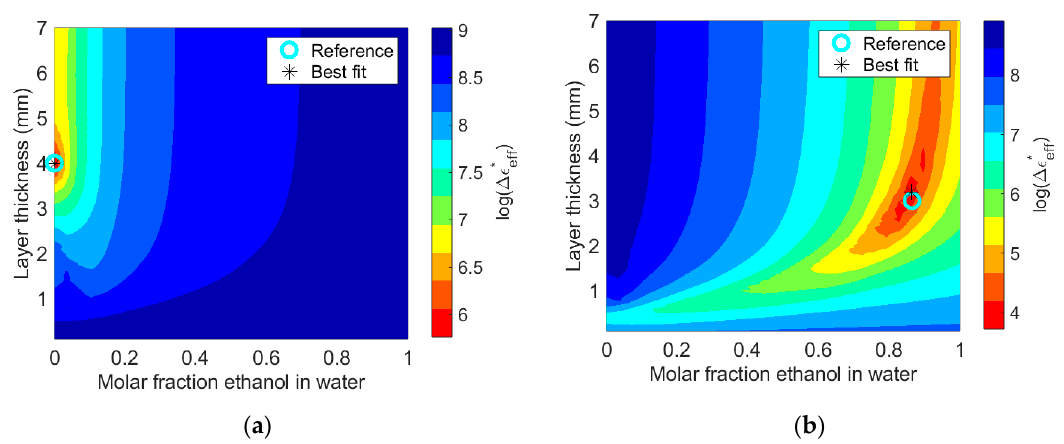
Figure 7. Plot of permittivity di ff erence between measured permittivity and simulated permittivity as calculated by Equation (4). ( a ) 4 mm water layer ( χ = 0). ( b ) 3 mm ethanol–water layer with χ =